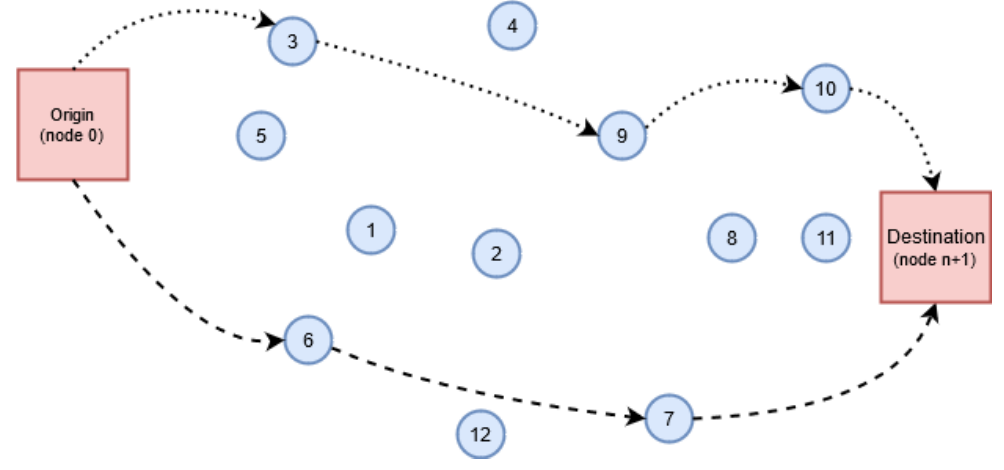
Figure 4. The Team Orienteering Problem